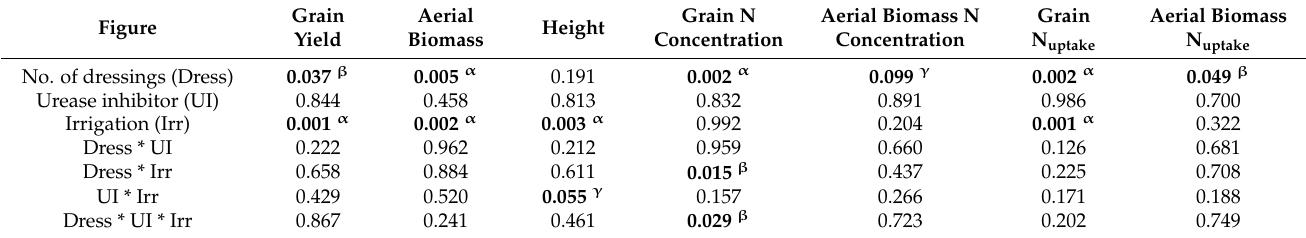
Table 2. The p -value for different factors in relation to its effect on the different measured variables. Significant differences among treatments in reference to a specific factor were highlighted in bold and with the letters α ( p < 0.01), β ( p < 0.05), and γ ( p < 0.10). * indicates interaction between factors.